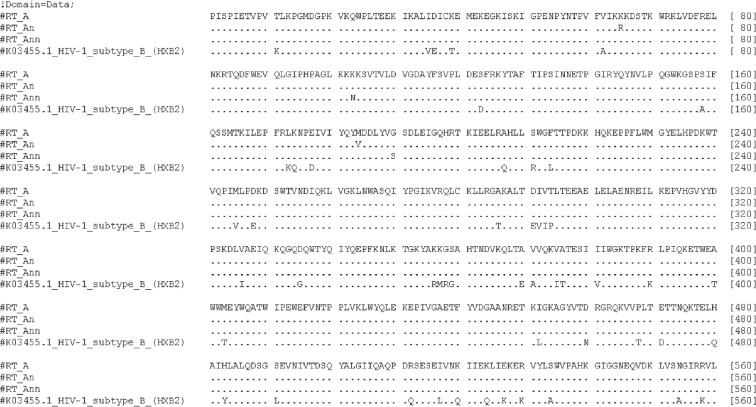
Alignment of the amino acid sequences of the consensus HIV-1 reverse transcriptase and its drug resistance variants designed in the study. “RT_A,” consensus of amino acid sequences (n = 44) of HIV-1 subtype A FSU_A strain isolated between 1999 and 2012, with amino acids in variable positions chosen using OMES-based covariance network. “RT_An,” RT_A variant with introduced mutations of resistance to NRTI K65R and M184V; “RT_Ann,” RT_A variant with introduced mutations of resistance to NNRTI K103N and G190S; “K03455.1 HIV-1 subtype B (HXB2),” reference sequence of HIV-1 subtype B RT used for position numbering [63].